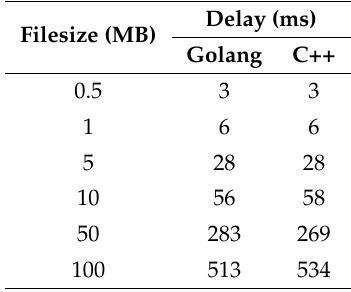
Table 1. Performance comparison of C++ and Golang in file